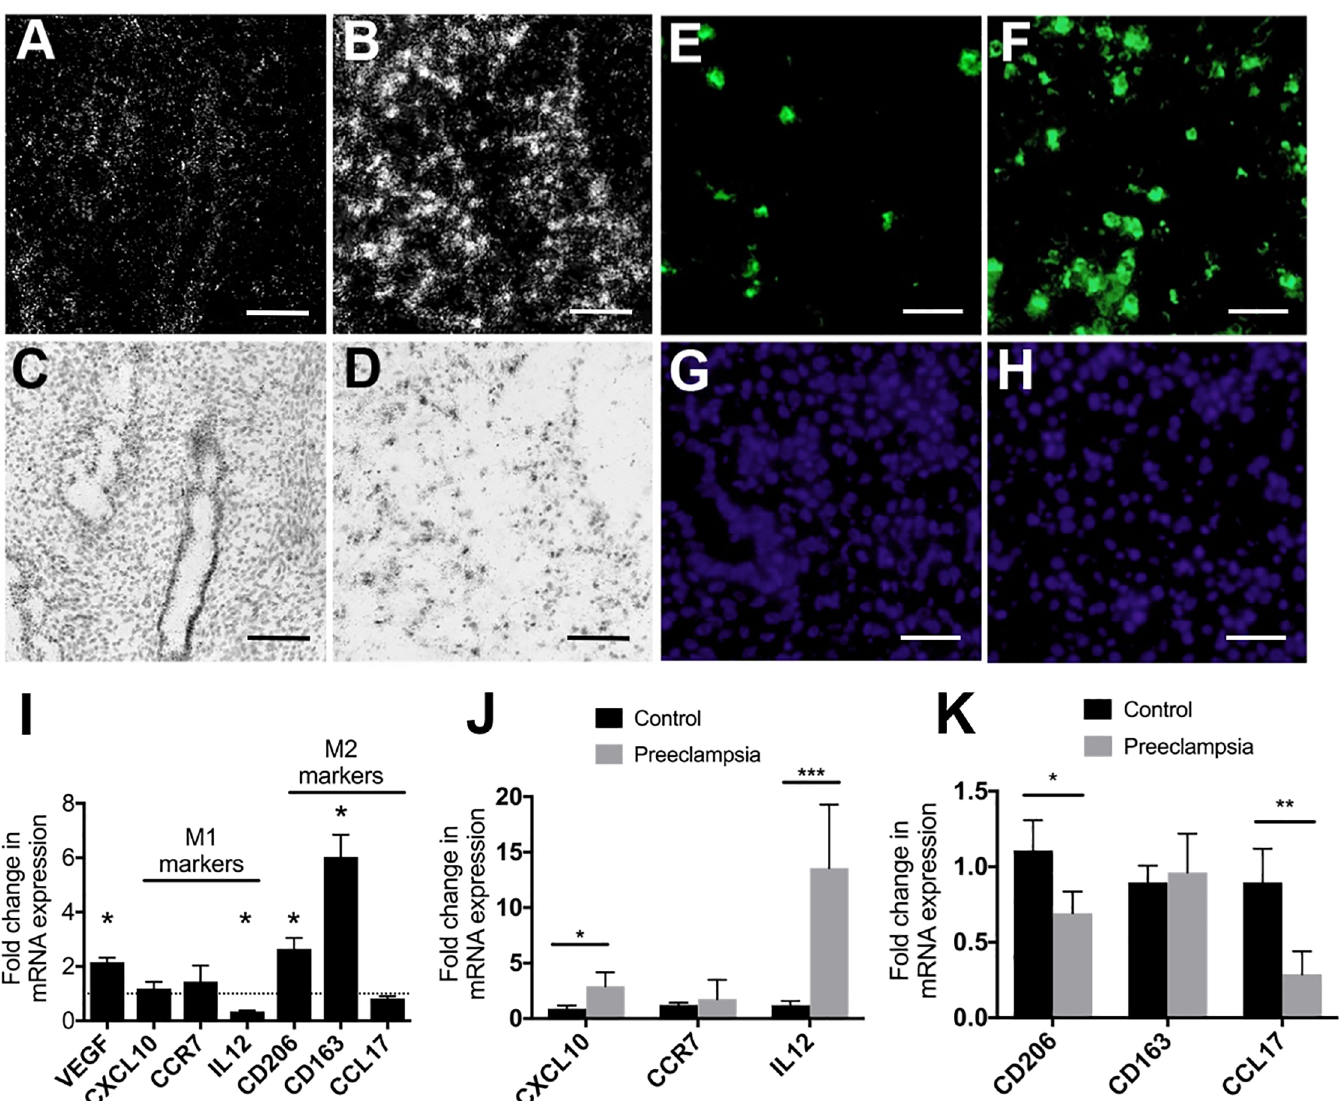
Fig 1. Increase in decidual VEGF expression is associated with increase in macrophage number and dramatic upregulation of M2 markers in the decidua. A-D, representative photomicrographs (in situ hybridization; A-B, dark-field images; C-D, bright-field images) show a marked increase in VEGF mRNA expression in first trimester decidua (B, D) as compared with secretory phase endometrium (A, C). Immunofluorescence (E-F, CD68 immunostaining; G-H, DAPI staining) show a concomitant increase in CD68-positive macrophages in first trimester decidua (F) as compared to secretory phase endometrium (E). Scale bars: A-D, 100 μm and E-H,